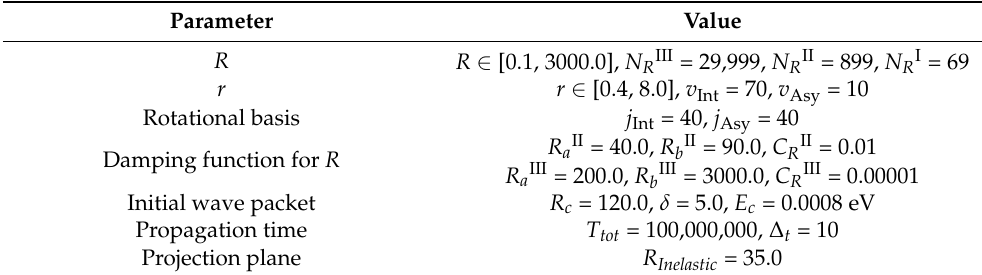
Table 2. Numerical parameters used in IALR-WP calculations for the Na(3p) + H 2 ( v = 0, 1) → Na(3s) + H 2 collisions at low